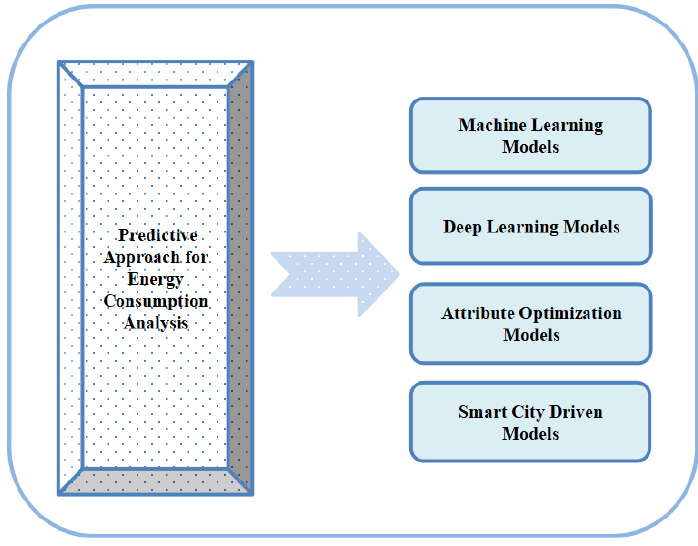
Figure 2. Structured approaches for energy consumption prediction.